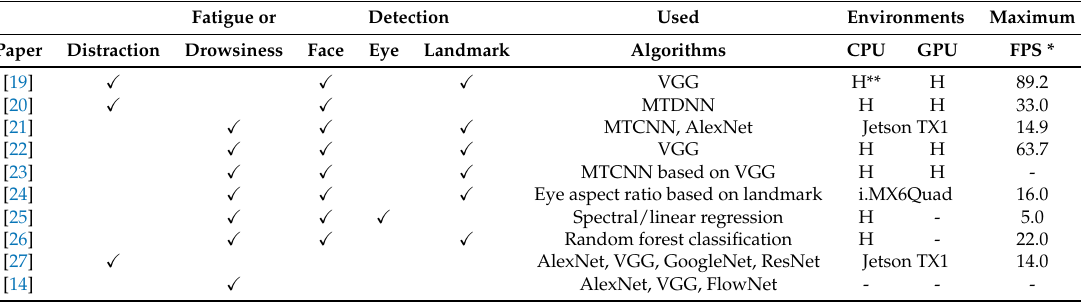
Table 1. Related works on the driver monitoring system.